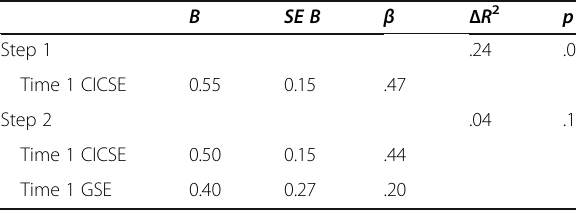
Table 6 Multiple regression analysis for time 2 CICSE